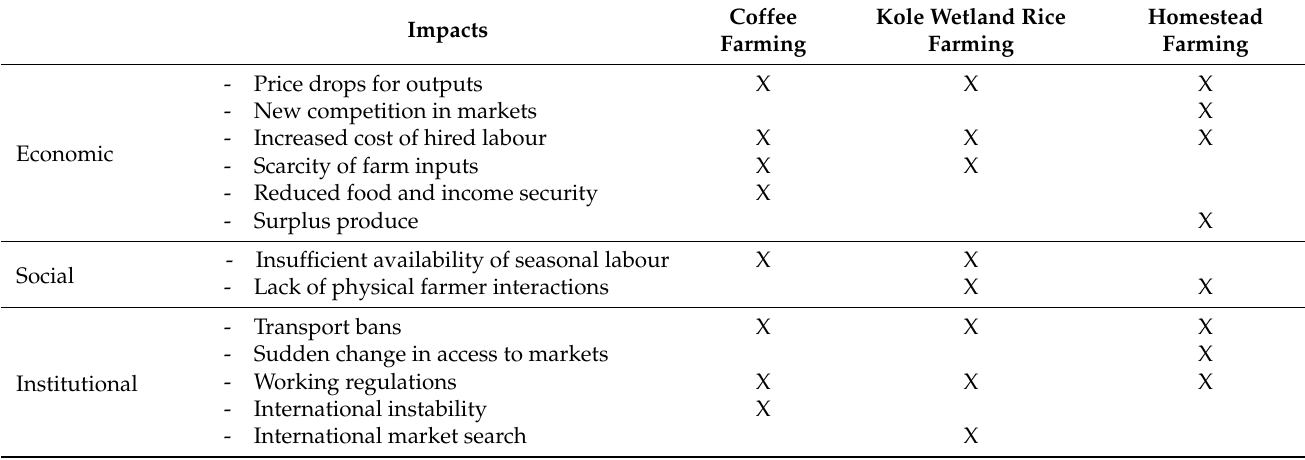
Table 1. Impacts of the COVID-19 pandemic on farming